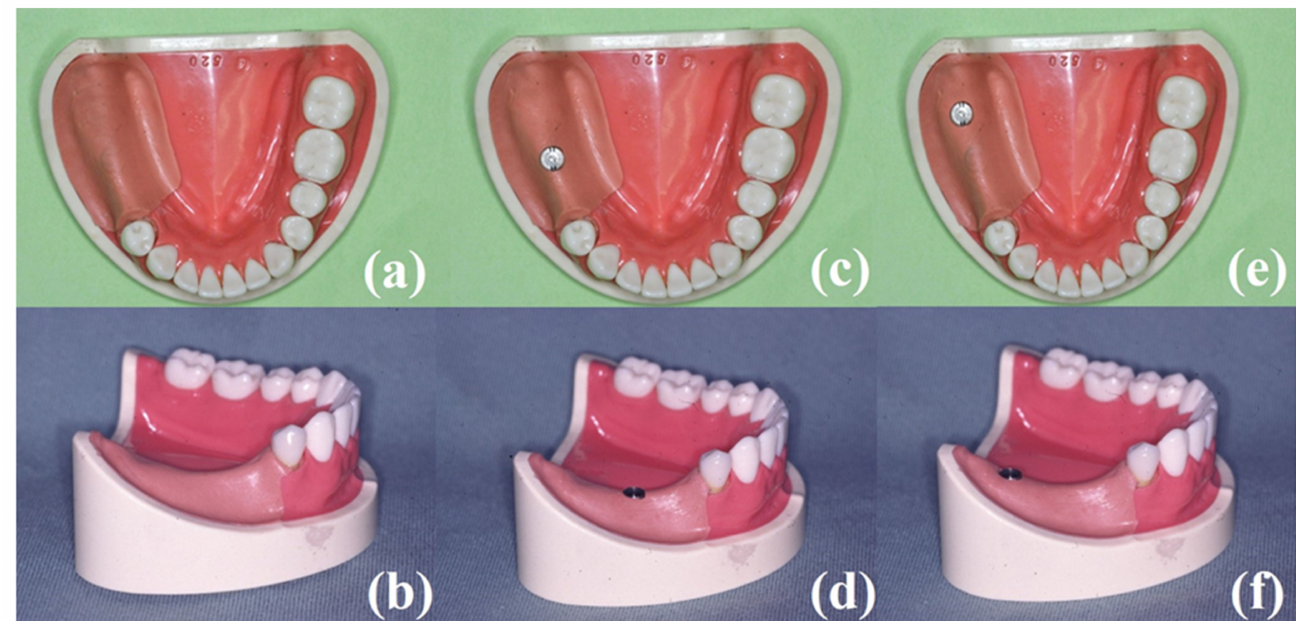
Figure 1. Images of simulated Kennedy class II partially edentulous mandibles: ( a , b ) partially edentulous mandibular Kennedy class II acrylic resin models without an implant; ( c , d ) mesially positioned implant-supported removable partial denture; ( e , f ) distally positioned implant-supported removable partial denture.